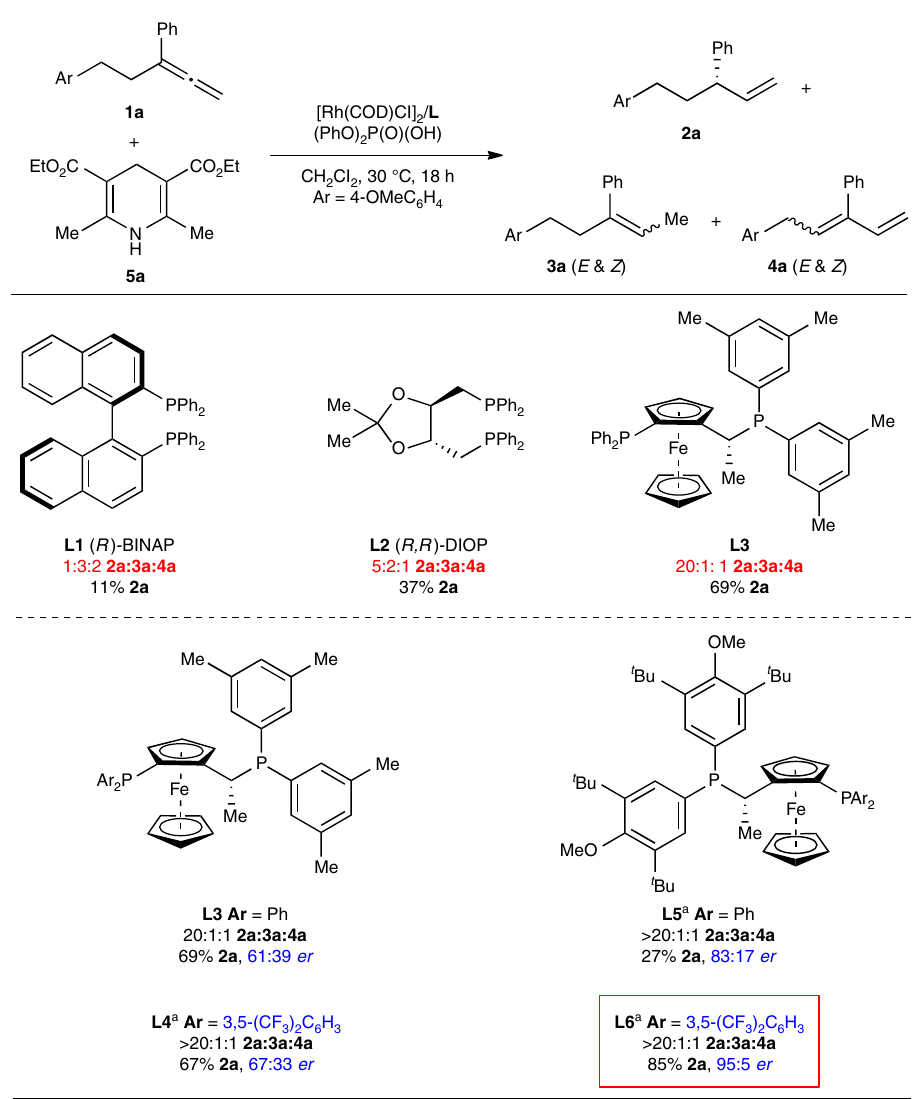
Fig. 3 Evaluation of chiral ligands. Reaction conditions: 1a (0.10 mmol), 5a (0.20 mmol), [Rh(COD)Cl] 2 (4 mol%), L (8 mol%), (PhO) 2 P(O)(OH) (8 mol%), CH 2 Cl 2 (0.2 mL), 30 °C, 18 h. Yields and product ratios were determined by 1 H NMR analysis of the unpuri fi ed reaction mixture using dimethyl terephthalate as an internal standard. Enantioselectivities ( er ’ s) were determined by chiral SFC analysis. a Using [Rh(COD)Cl] 2 (2 mol%), L (4 mol%), (PhO) 2 P(O)(OH) (4 mol%), CH 2 Cl 2